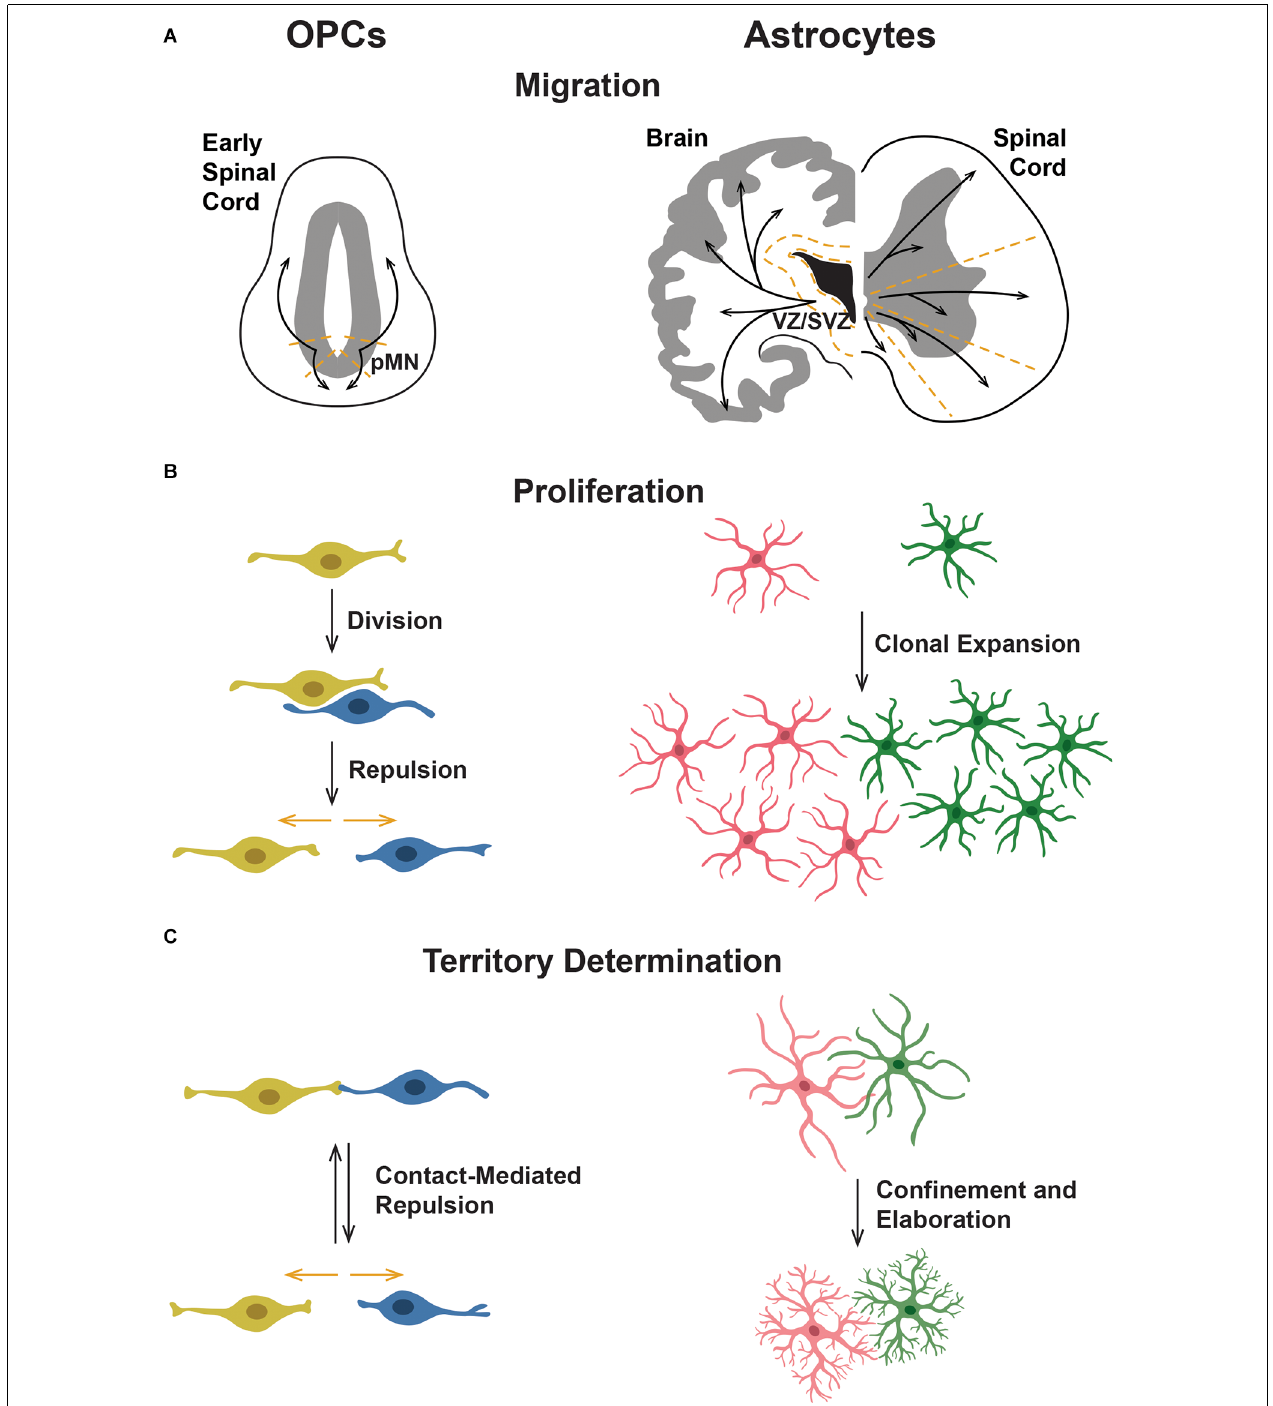
FIGURE 1 | Comparison of oligodendrocyte progenitor cell (OPC) and astrocyte tiling behaviors. (A) OPCs migrate ventrally and dorsally from their origin in the ventral spinal cord motor neuron progenitor (pMN) domain. Astrocytes originate in the ventricular (VZ) and subventricular zones (SVZ) and migrate throughout the gray and white matter of the CNS. In the spinal cord, astrocytes migrate radially into separate domains. (B) OPCs divide and then are repelled from one another through CMR, leading to an equal spread across the neuropil. In astrocytes, pioneer astrocytes spread throughout the CNS and then clonally divide to cover the neuropil. (C) OPCs form their domains through CMR, during which contact between two OPCs leads to both OPCs retracting their processes and moving away from one another. This process occurs throughout the life of an OPC, leading to equilibrium. In contrast, immature astrocytes overlap extensively and then establish their domains over time. Astrocyte processes become more elaborately branched yet are more confined, suggesting some sort of retraction or pruning of processes.